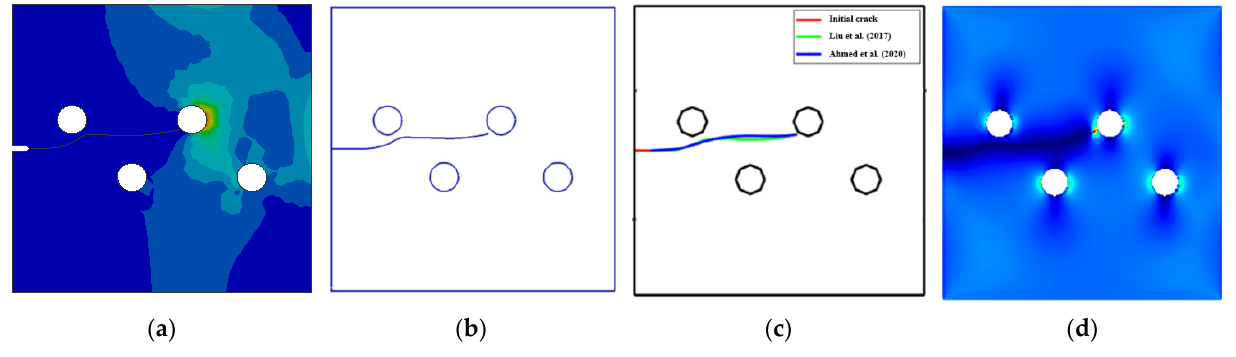
Figure 11. Crack propagation paths: ( a ) present study, ( b ) Liu et al. FMM BEM [46], ( c ) Ahmed et al. [47], and ( d ) Wiragunarsa et al. [48].